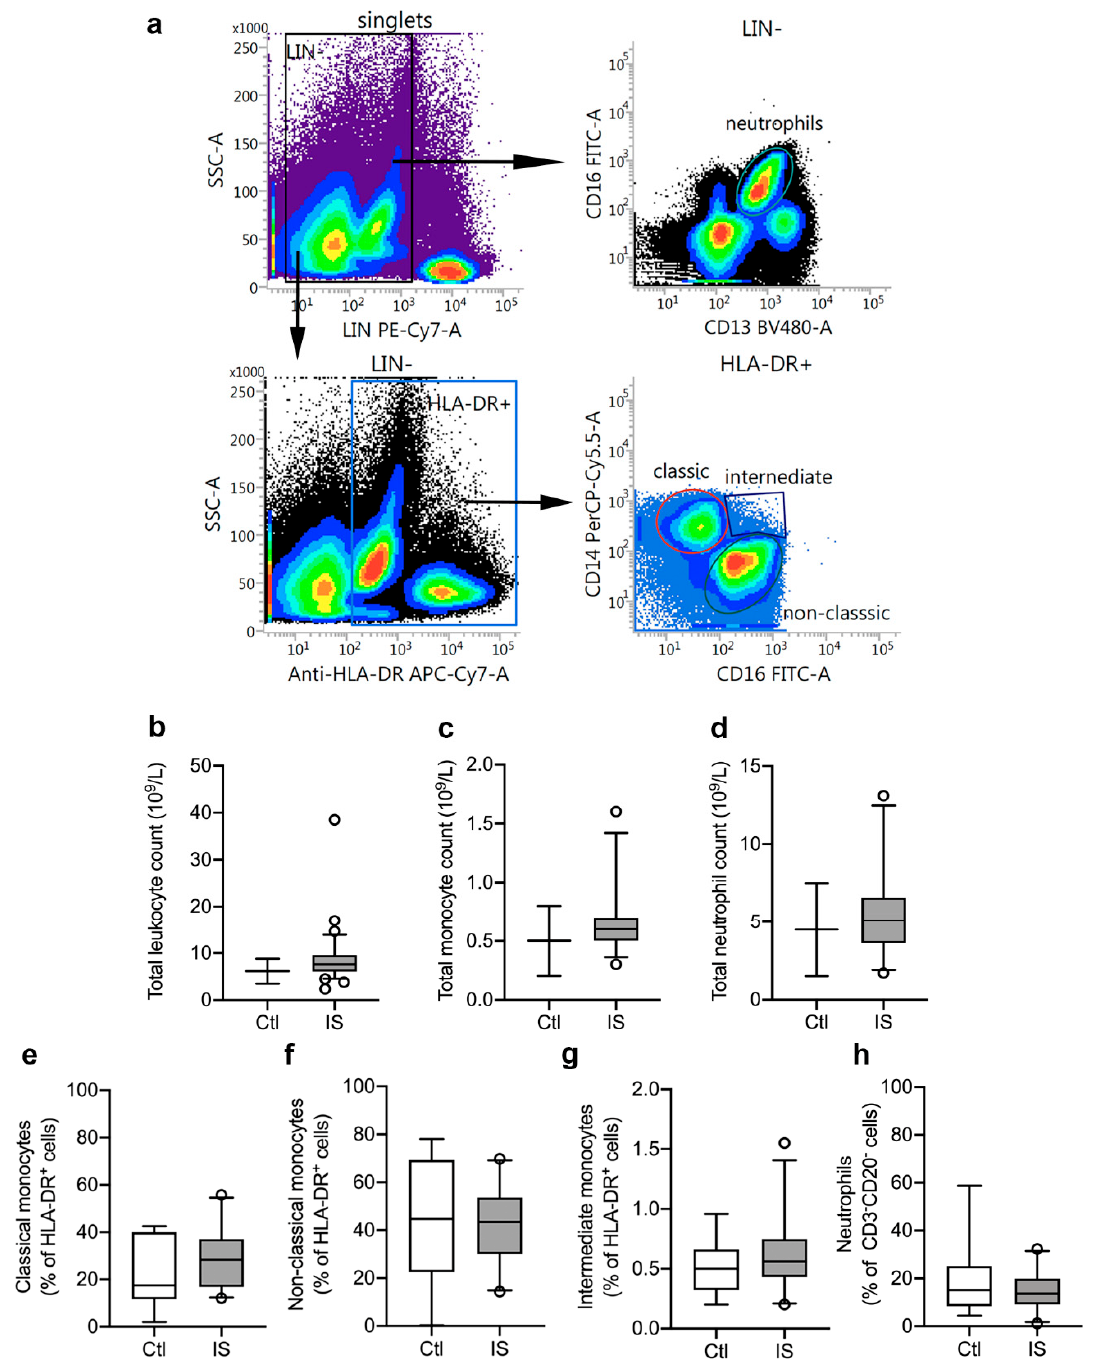
Figure 1. Characterization of leukocyte populations in ischemic stroke (IS) patients. ( a ) Flow cytometry gating strategy for blood monocyte subsets and neutrophils. Peripheral blood monocytes were identified as LIN − (CD3 and CD20) HLA-DR + cells and neutrophils as LIN − (CD3 and CD20) CD16 + CD13 + cells (yellow gated population). The monocyte population comprised classical monocytes (CD14 ++ CD16 − : red gated population), intermediate monocytes (CD14 ++ CD16 + : blue gated population), and non-classical monocytes (CD14 + CD16 ++ : green gated population). ( b – d ) Total leukocyte count ( b ), total monocyte count ( c ), and total neutrophil count ( d ) in IS patients ( n = 33) compared to the normal population range (control, Ctl). ( e – h ) Quantification of classical monocytes ( e ), non-classical monocytes ( f ), intermediate monocytes ( g ), and neutrophils ( h ) in IS ( n = 23) and healthy Ctl ( n = 8). Line: median. Box: 25–75% interquartile range. Whiskers: 5–95% percentile.